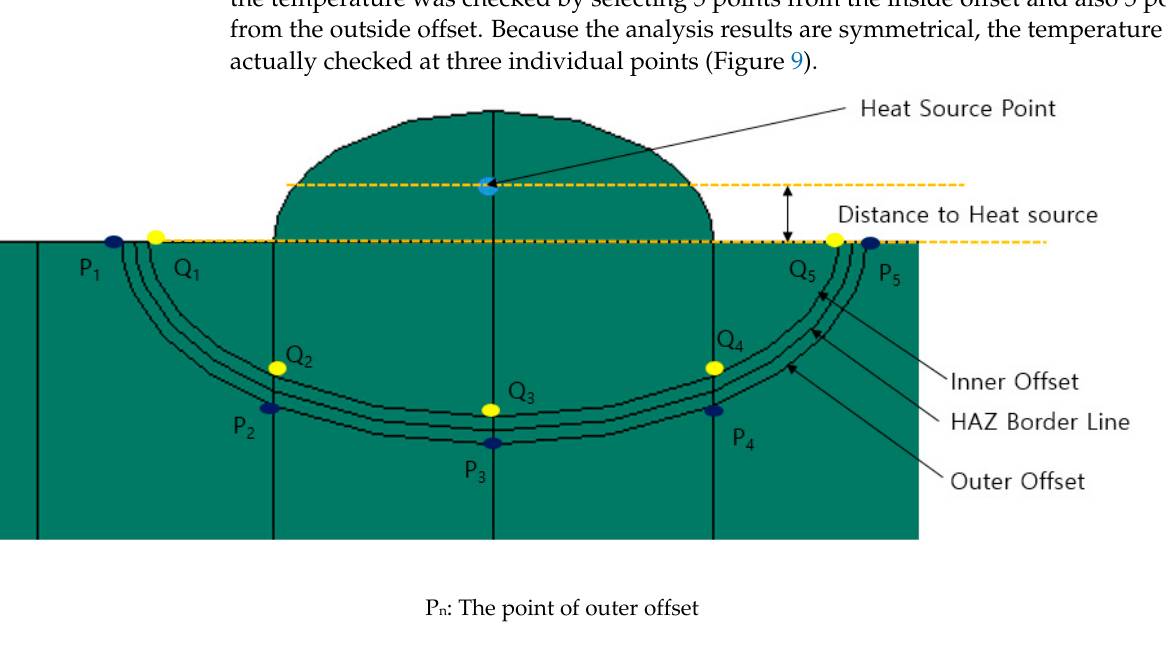
Figure 9. Offset shape, temperature checking position, definition of distance to heat source.